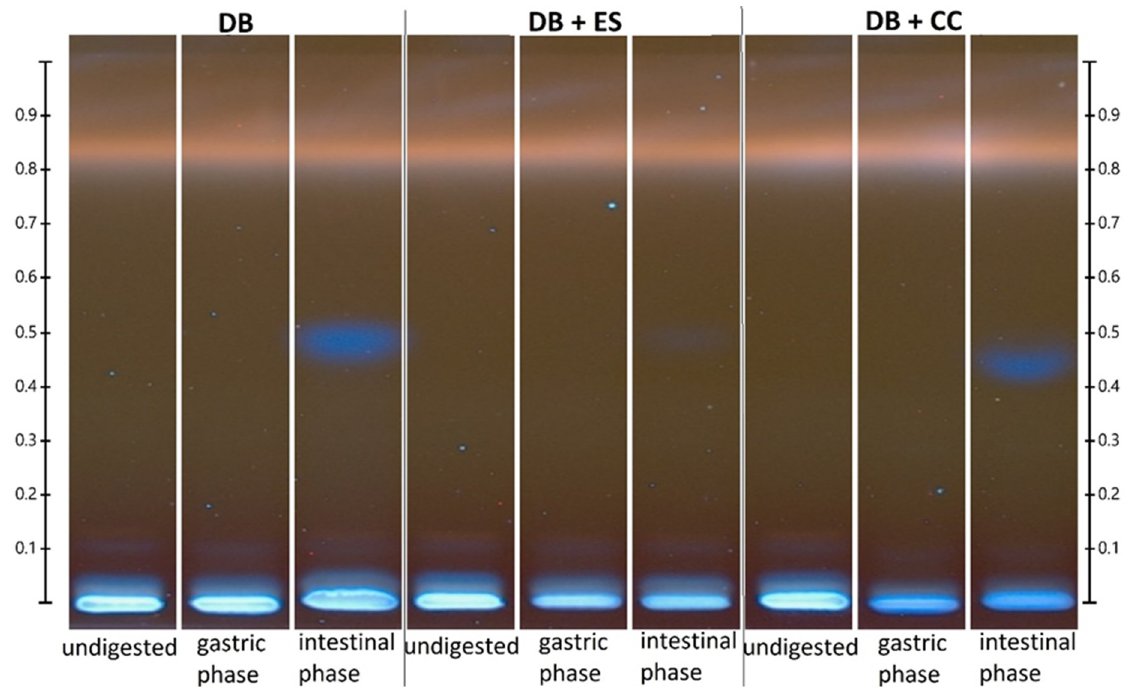
Figure 5. The change of the polyphenolic pro fi le of prepared supplements DB + ES and DB + CC during in vitro digestion. during in vitro